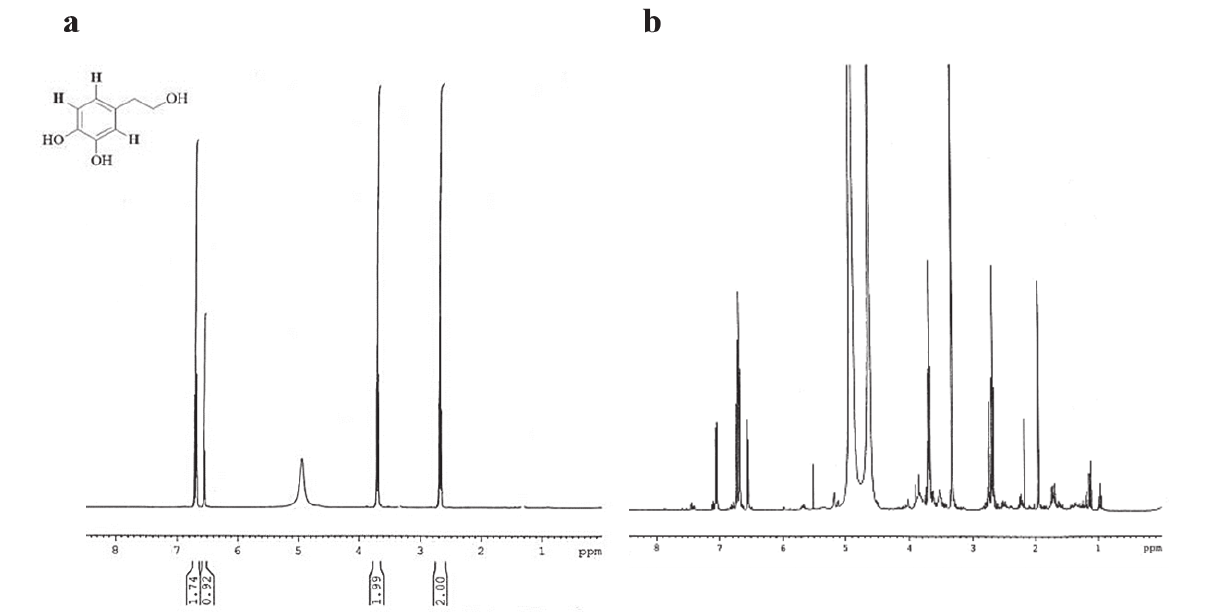
Figure 2. 1 H-NMR spectra of HTyr (a) and HTE2 (b).